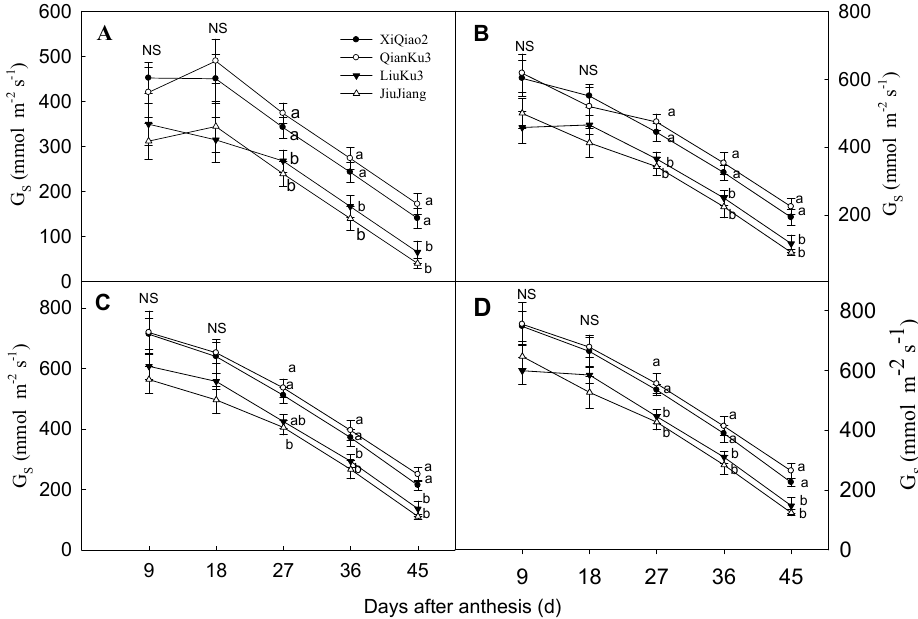
Figure 4. Stomatal conductance (G S ) in the leaves of four Tartary buckwheat cultivars at different flowering nodes. Panels ( A – D ) show results for the leaves of the 6th, 7th, 8th, and 9th flowering nodes, respectively. Data are means ± SD of two years (2016 and 2017). Letters a and b denote significant differences between cultivars ( p < 0.05) in G S at the same day after anthesis. NS: no significant difference.